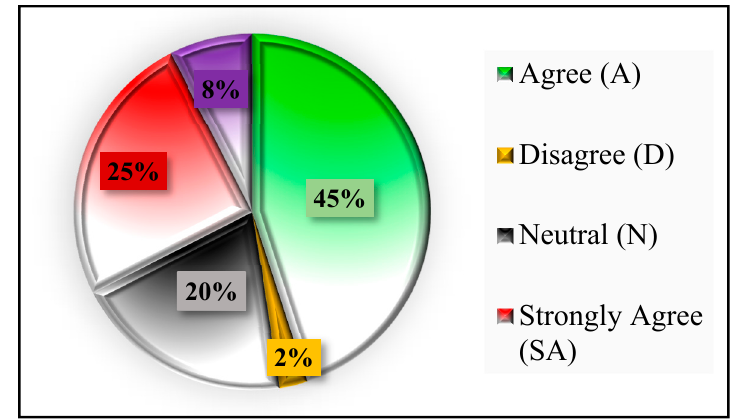
Figure 8. Proper scheduling under the lean methodology .